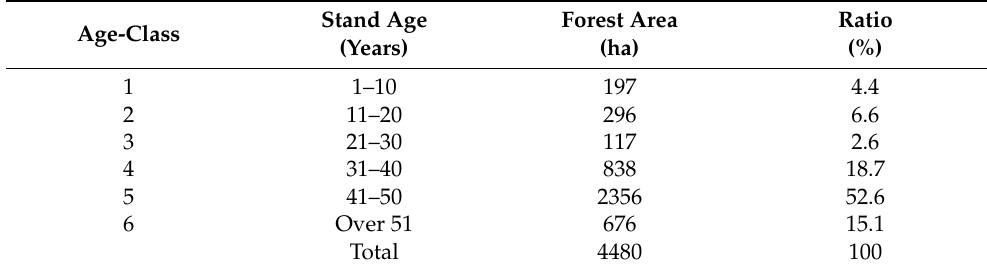
Table 1. Age-class distribution of forest stands in the study area [29].